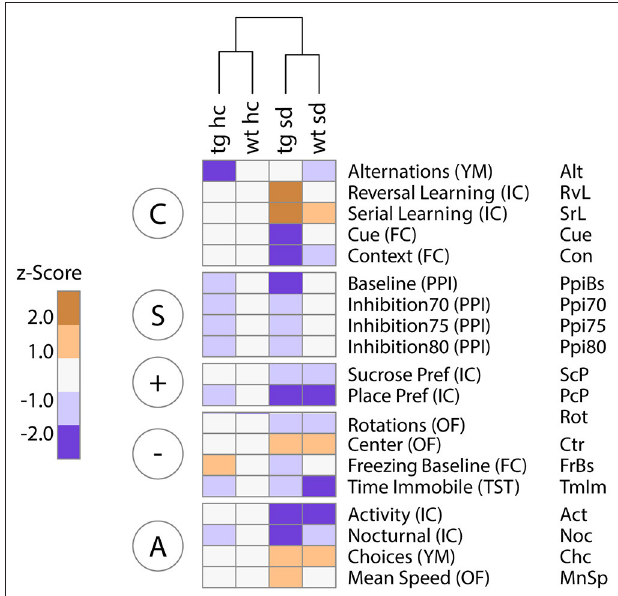
FIGURE 5 | RDoC grouping of z -scored data reveals domain-specific differences in the contribution of Tcf4 gene dosage and psychosocial stress to behavioral and cognitive dysfunction. Unsupervised hierarchical clustering of group means of standardized ( z -scored) behavioral data clusters primarily by environmental stress. The heatmap highlights changes relative to the healthy control group [wildtype no stress control (wt ns)]. The most prominent effects are seen for the two-hit disease group Tcf4 tg mice subjected to social defeat during adolescence (tg sd). Particularly, deficits in the cognitive domain (“C”) are dependent on both genetic and environmental impact, in contrast to more generally stress-dependent abnormalities in the positive (“ + ”) and negative (“–”) valence as well as the arousal/regulation domain (“A”). The sensorimotor gating system (“S”) clearly separates animals based on Tcf4 gene dosage only. Column blocks are defined by RDoC domains; n =